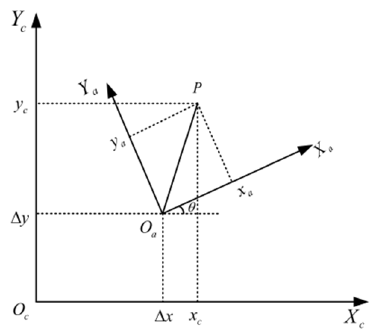
Figure 14. Coordinate system conversion relationship.